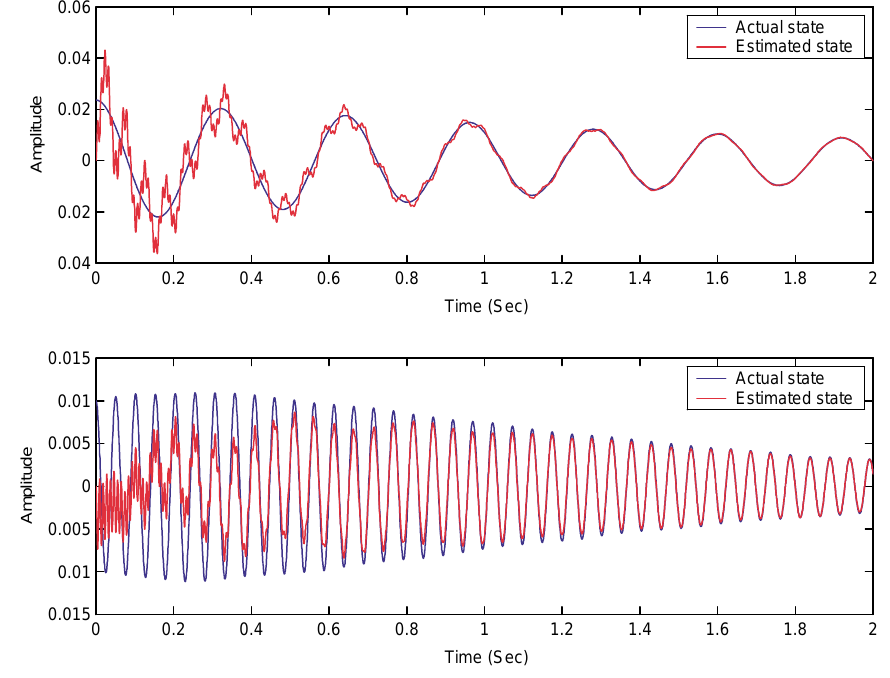
Fig. 6. State estimation performance of Luenburger observer with 180 Hz disturbance.